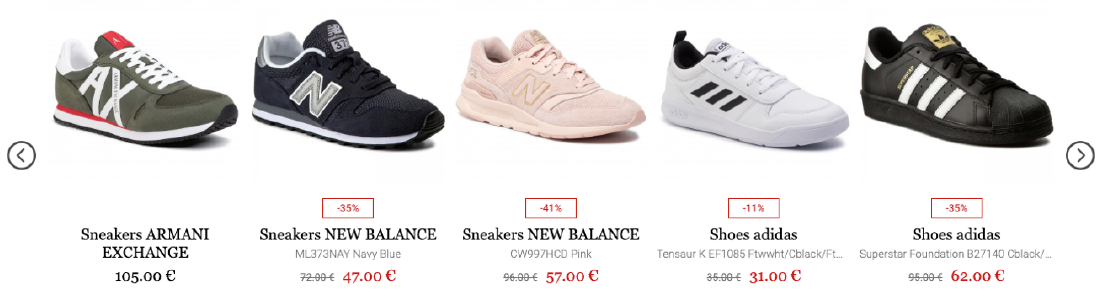
Figure 3. Recommendation box at main page of a service—personalised on user interactions in the same session. (The figure is from a Polish vendor, so there is a comma instead of a dot in numbers).